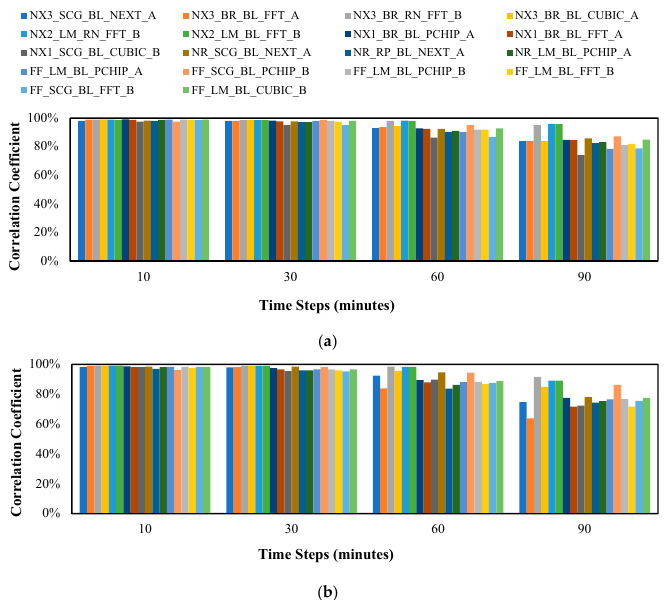
Figure 7. The 18 best-performing variations in terms of the correlation coefficient ( R ) for ( a ) wind speed prediction, and ( b ) wind direction prediction, at different time horizon (i.e., 10, 30, 60, and 90 min). Note that 500 samples were used; each of which is a 10 min interval. This results in a total of ~83 h.